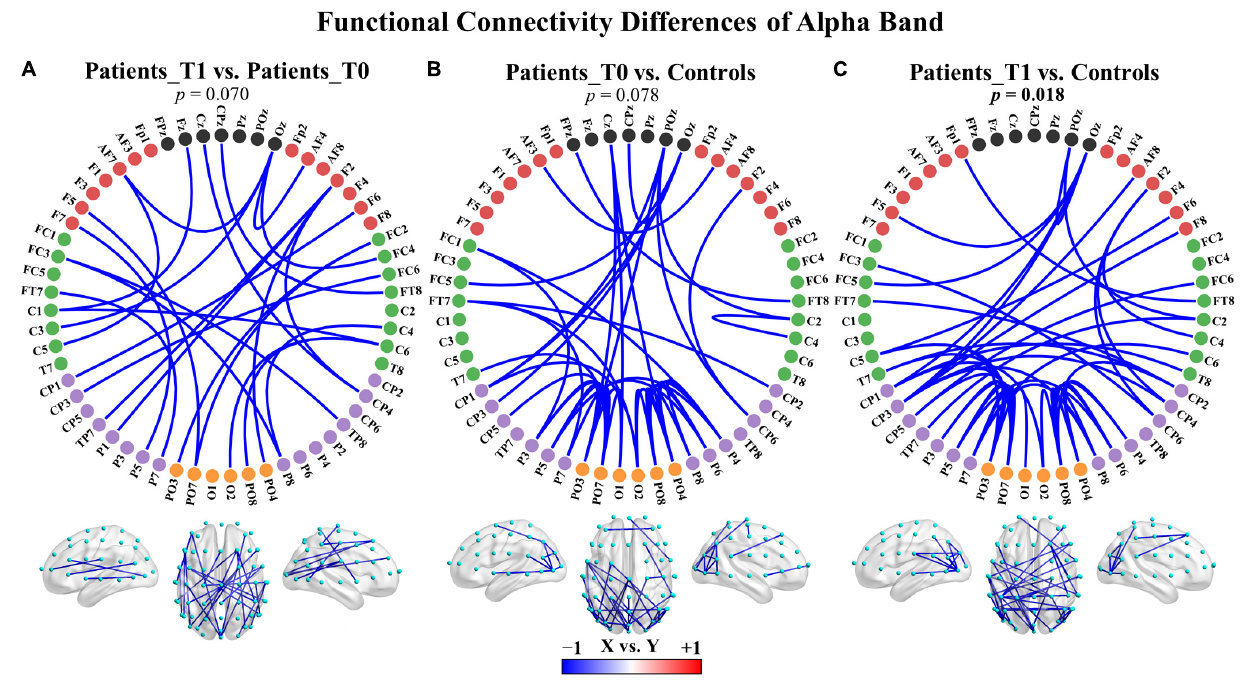
FIGURE 3 | Group differences in functional connectivity of the alpha band. (A) Patients at T1 vs. patients at T0. (B) Patients at T0 vs. controls. (C) Patients at T1 vs. controls. The depth of color indicates the size of the connectivity difference. For X vs. Y , the blue color indicates X < Y ; the red color indicates X > Y . For each comparison, only the top 50 connections with the smallest observed p -values in the connected component with the smallest p -value are displayed. The complete connections of the connected components are provided in Supplementary Figure 5 . Bolded p -values indicate significant